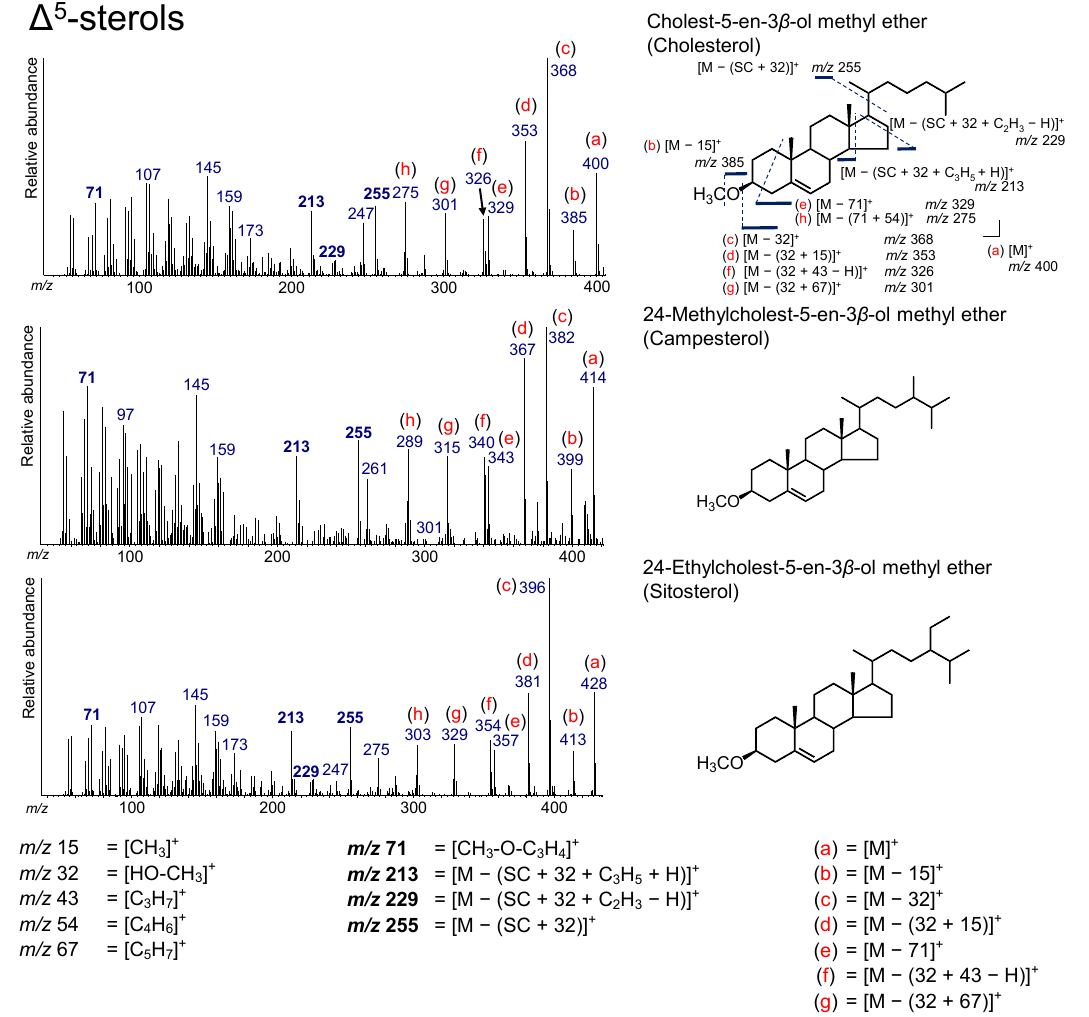
Figure 5. Electron ionization (70 eV) mass spectrum of ∆ 5 -sterol. Bold numbers indicate an ion that accompanies the cleavage of the side chain. ( a )–( h ) Ions that are not accompanied by the loss of the side chain or other